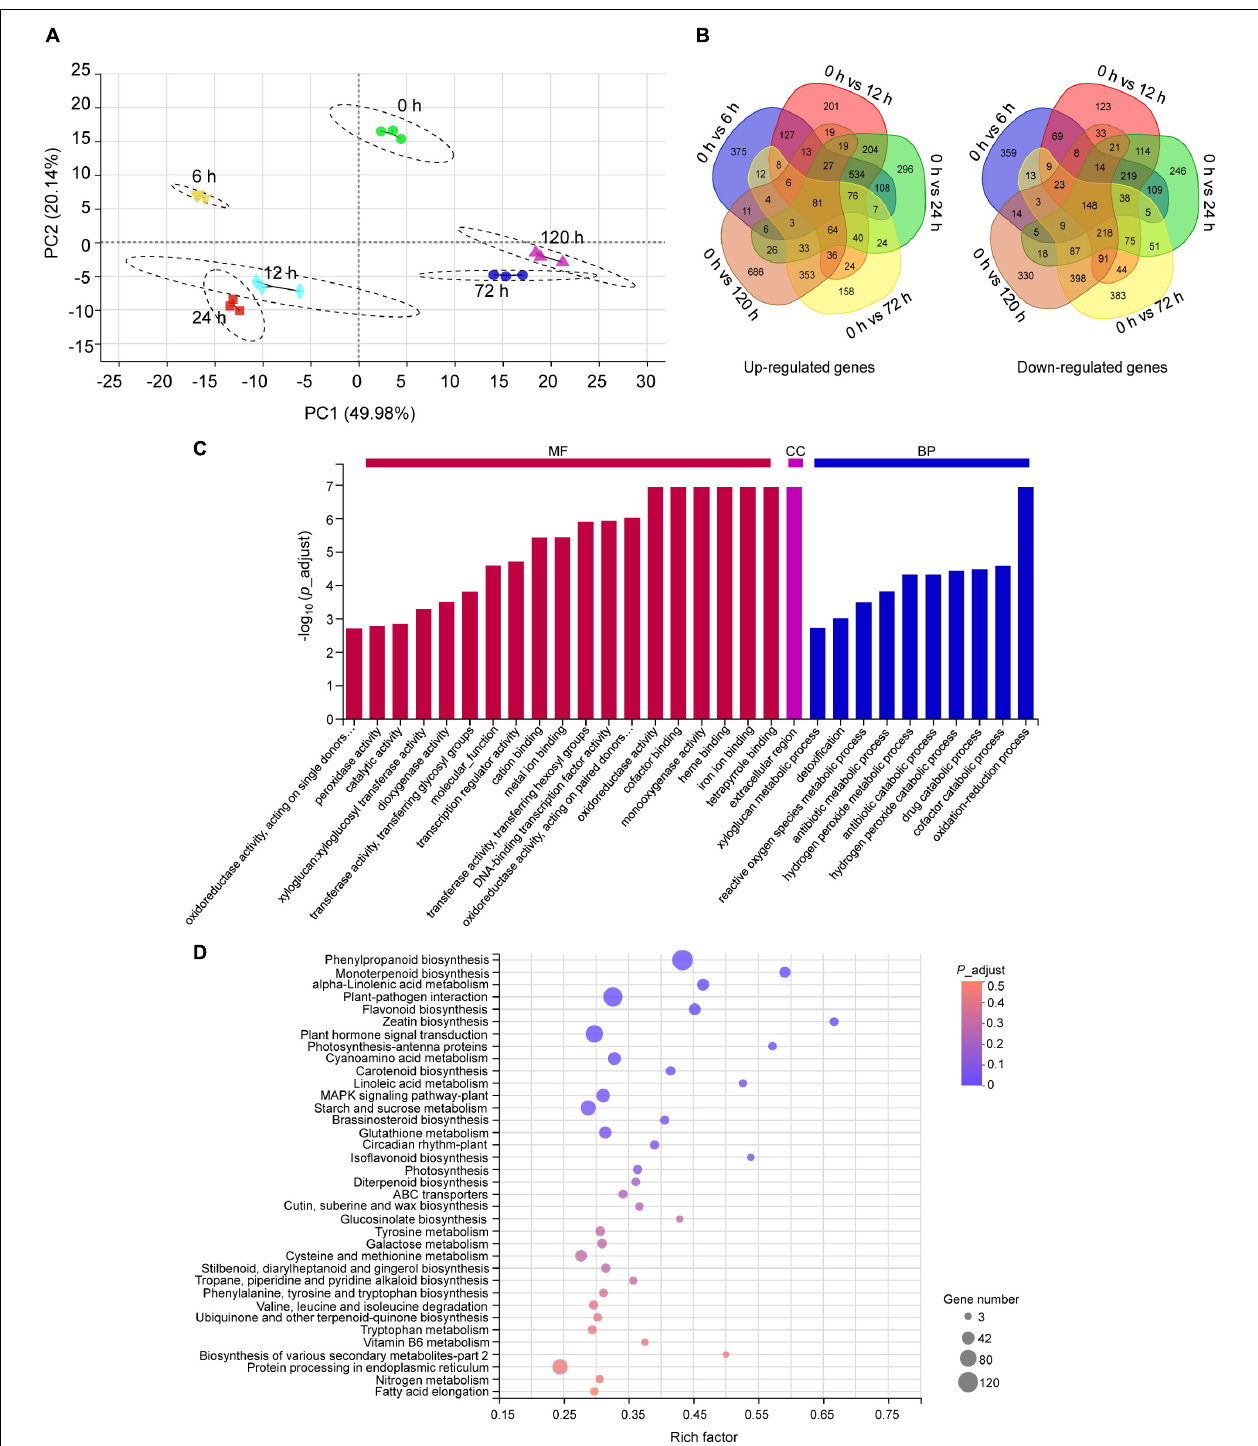
FIGURE 3 | Transcriptome analysis of peach roots treated with 0.4 mM BA. (A) Principal component analysis (PCA) of transcriptomic data. (B) Venn diagram display of all upregulated and downregulated differentially expressed genes (DEGs) across different time intervals. (C) Summary of Gene Ontology (GO) categories of the DEGs. MF, molecular function; CC, cellular component; BP, biological process. (D) The Kyoto Encyclopedia of Genes and Genomes (KEGG) pathway enrichment scatter map. The bubble size represents the number of DEGs detected in the corresponding pathway. The larger bubble diameter means more DEGs annotated to this pathway. The rich factor is the ratio of DEGs to the total background gene number in each pathway. The color of the bubble changed from red to purple, indicating that the P- adjust gradually decreases. When P -adjust < 0.05, the pathway is defined as a significantly enriched one.